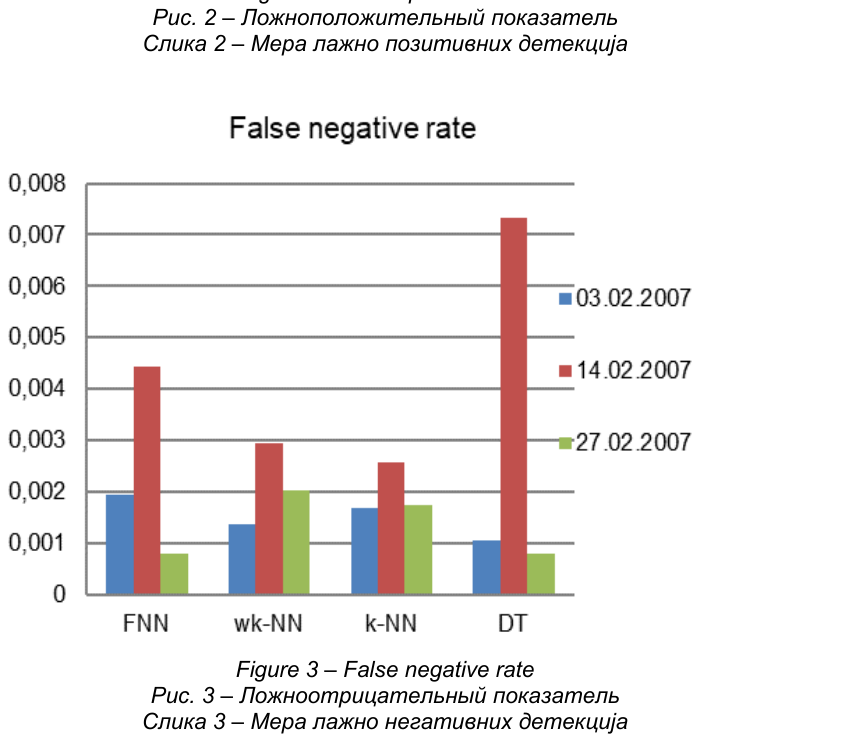
Figure 3 – False negative rate Рис . 3 – Ложноотрицательный показатель Слика 3 – Мера лажно негативних